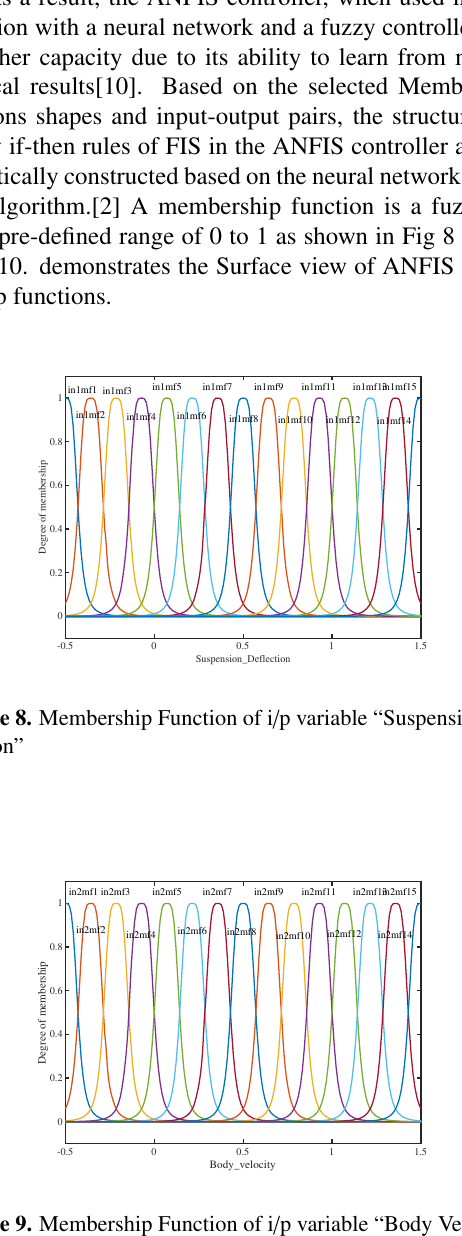
Figure 9. Membership Function of i / p variable “Body Velocity”